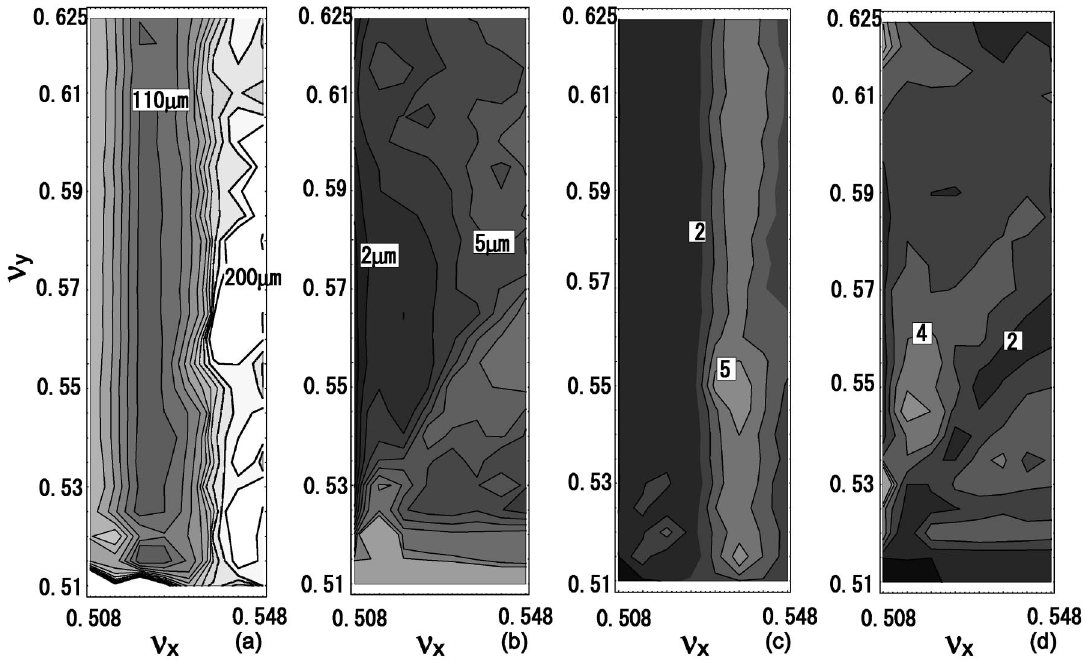
FIG. 8. Beam size and kurtosis in x - y tune space for crossing angle of 11 mrad. The horizontal and vertical beam sizes are depicted in (a) and (b), respectively. The horizontal and vertical kurtosis are depicted in (c) and (d), respectively. The contour lines are drawn every 10 + m , 1 + m , and 1 for horizontal, vertical beam size, and kurtosis, respectively, and lighter gray corresponds larger beam size and